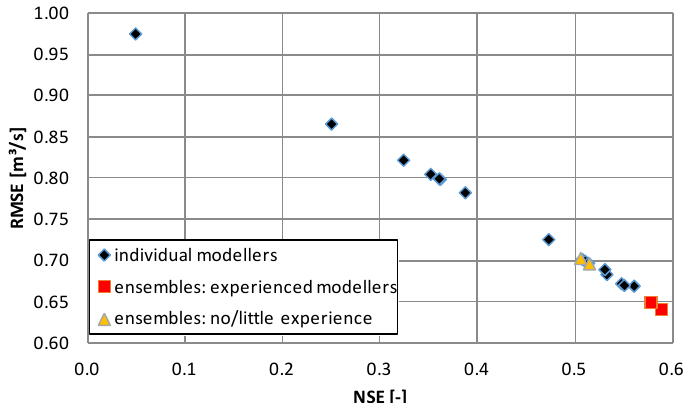
Figure 8. Comparison of individual model applications (blue diamonds) against model(er) ensembles (median, mean) based on the results of the experienced modellers (red squares) compared to the less or even unexperienced modellers (yellow triangles). For graphical reasons, the results of one modeller are not shown who achieved an NSE value of − 45.9.